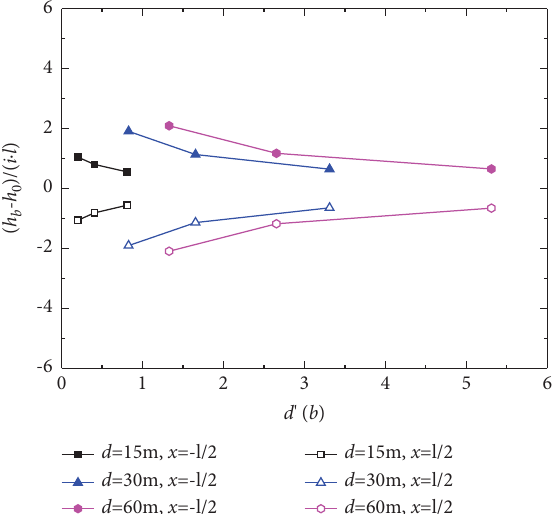
Figure 14: Variation in the MWLIR with the efective depth-width ratio of the